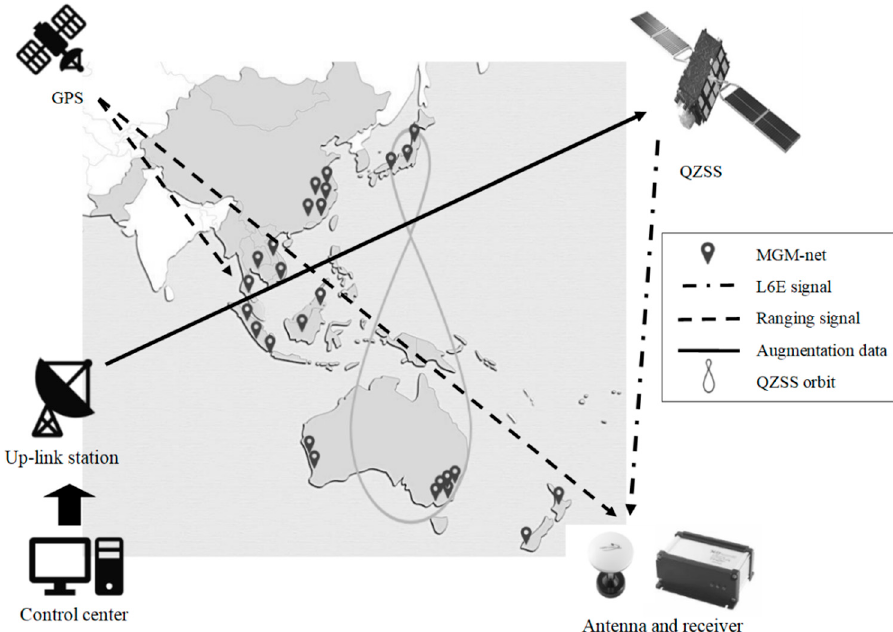
Figure 3. Diagram of the Multi-Global Navigation Satellite System (GNSS) Advanced Demonstration tool for Orbit and Clock Analysis (MADOCA) positioning augmentation system.